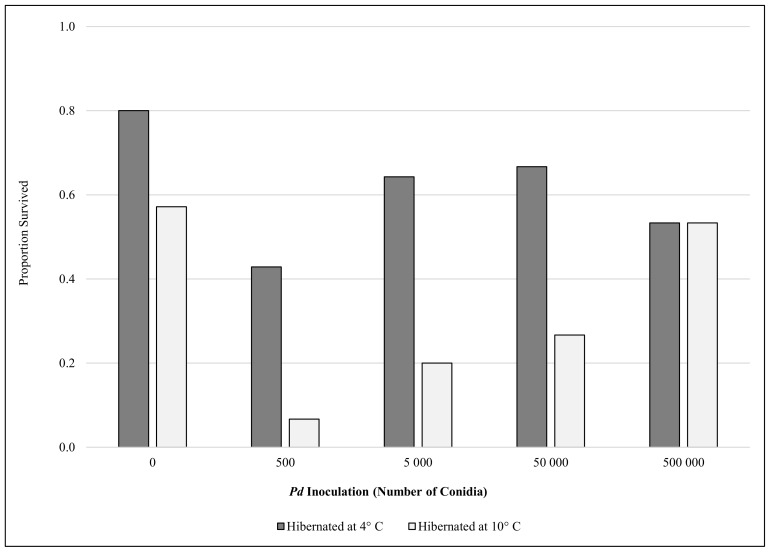
Comparison of survival rates (percent) for little brown myotis (Myotis lucifugus) inoculated with different doses of Pseudogymnoascus destructans (Pd) conidia and hibernated for five months at either 4 or 10°C.